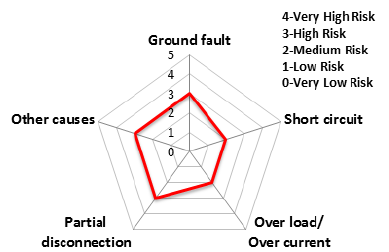
Figure 11. The risk rating for electrical fires in Seoul.